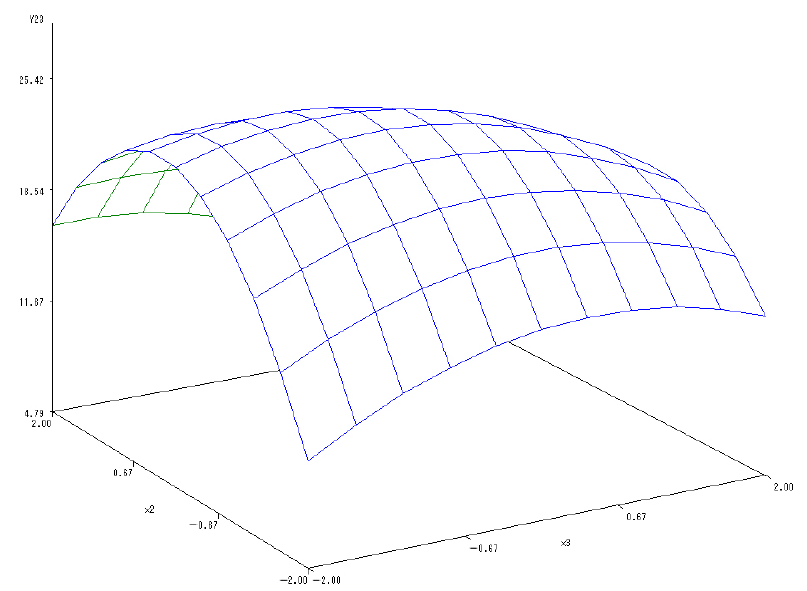
Figure 8. The 3-D map of mutual effect of P and K fertilizers application on Vc content in melon.